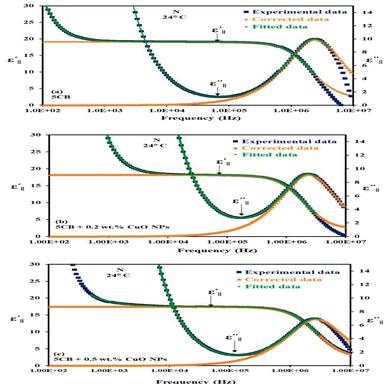
Frequency dependence of longitudinal component of the permittivity (ε ′ ‖) and loss (ε′′ ‖ ) for (a) Pure 5CB at 24 ◦C. (b) 5CB + 0.2 wt% CuO NPs at 24 ◦C. (c) 5CB + 0.5 wt% CuO NPs at 24 ◦C. Curves show experimental data (squares), corrected data (triangles) and data obtained by fitting (circles) respectively.